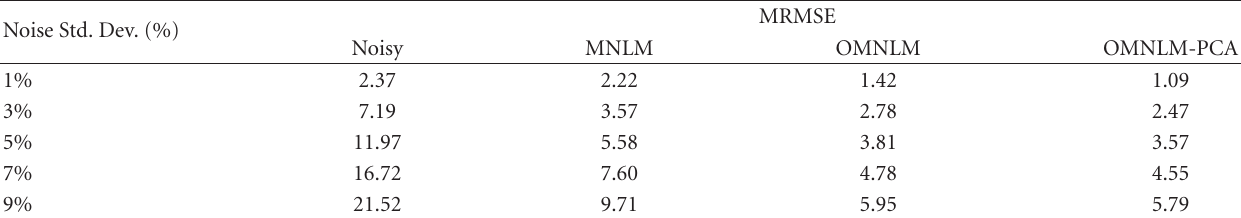
Figure 2: From left to right: synthetic noise free T1, T2, and PD (low and high flip angle) weighted MR images. Table 1: Comparison of the MNLM and proposed filters for di ff erent noise levels. MRMSE from all the images is presented. MRMSE of the unprocessed images is presented for